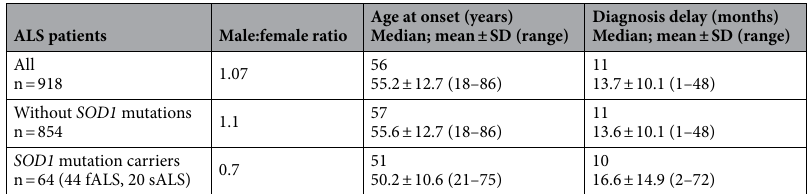
Table 1. Demographic data of patients with amyotrophic lateral